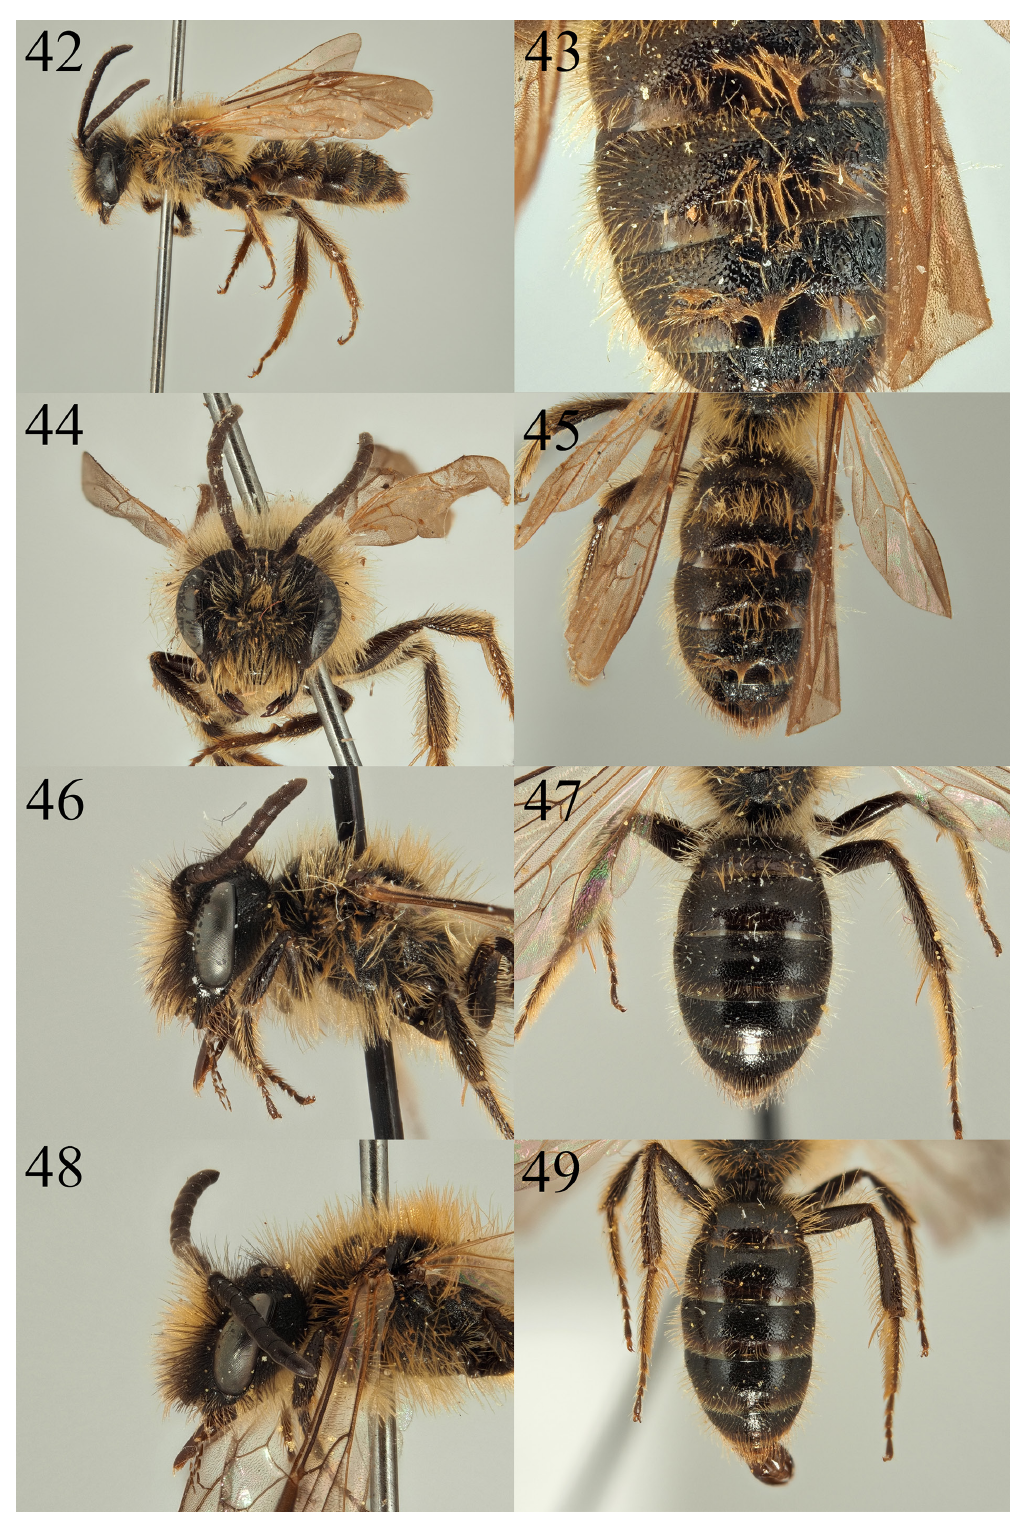
Figs 42–49. 42–45. Andrena fortipunctata Wood sp. nov. (NMNL). 42 . Male profile. 43 . Male terga detail. 44 . Male face. 45 . Male terga. — 46–47 . Andrena vulpecula Kriechbaumer, 1873 (TJWC). 46 . Male face, profile. 47 . Male terga. — 48–49 . Andrena granulosa Pérez, 1902 (TJWC). 48 . Male face, profile. 49 . Male terga. Not to